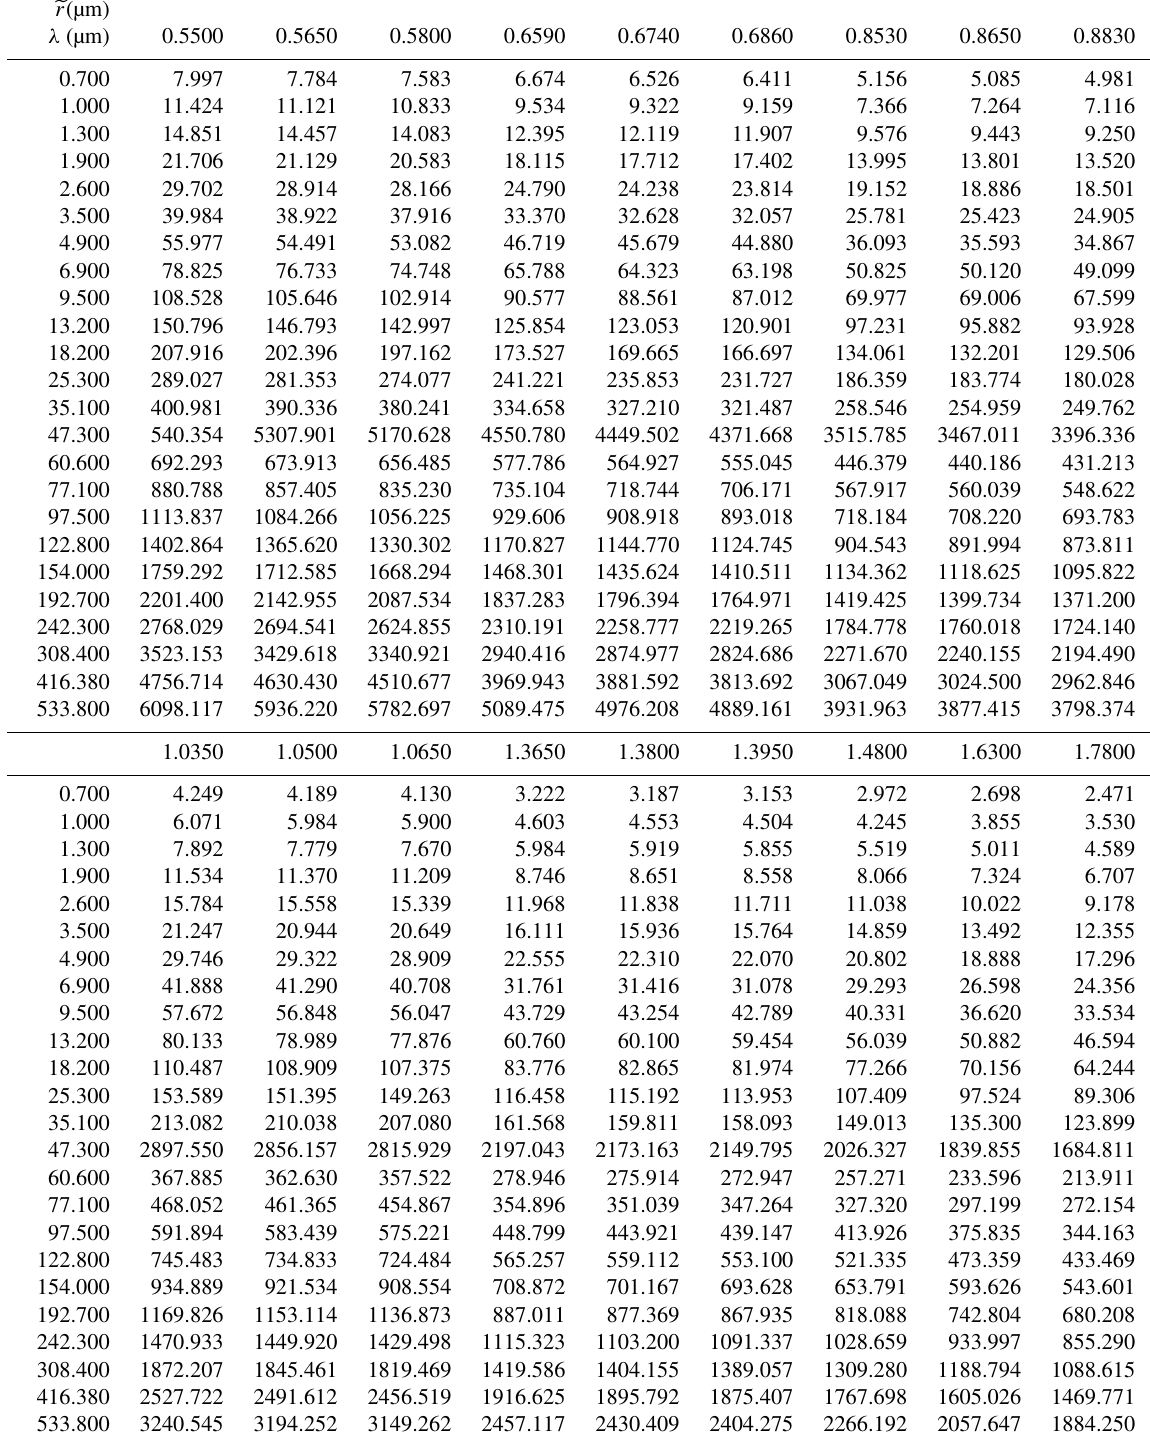
Table 2. Size parameter with various particle size and calculating wavelength on the SGLI channels (FDTD, GOIE, GOM). e r (µm) λ